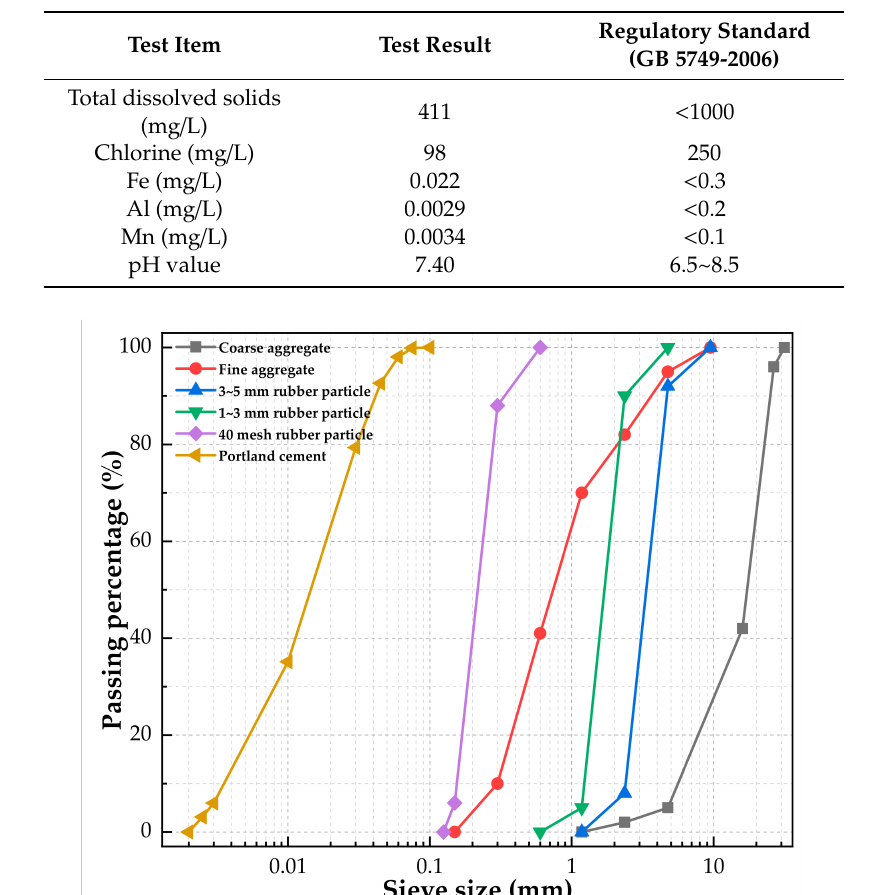
Figure 1. Particle size distribution of aggregate and rubber